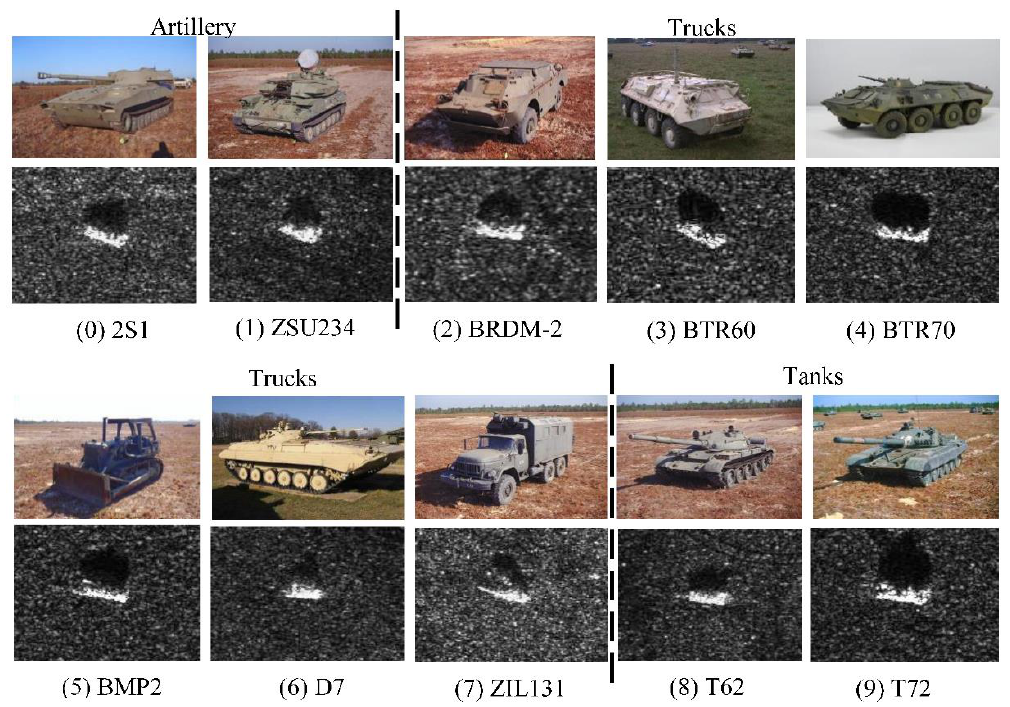
Figure 4. Optical and SAR images of 10 classes of targets in the MSTAR database.